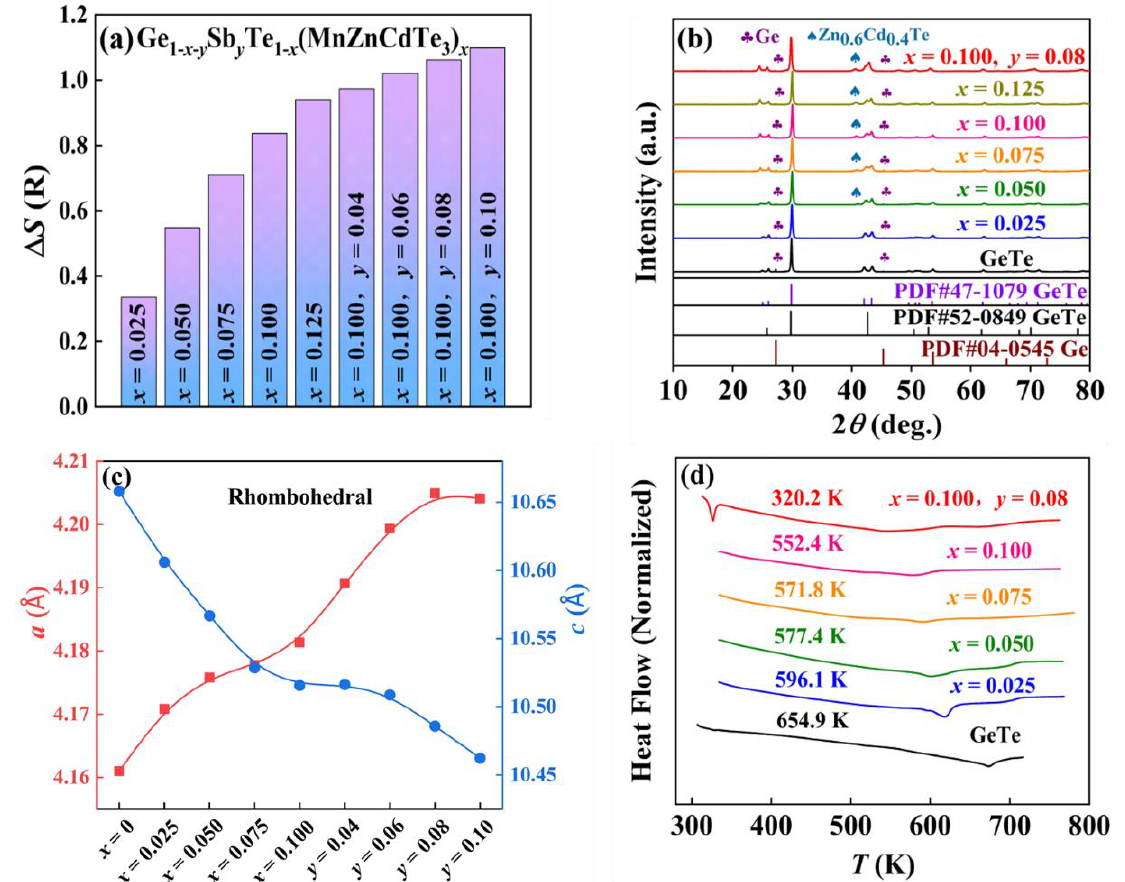
Figure 1. Room temperature ( a ) configurational entropy Δ S , ( b ) powder XRD patterns, ( c ) lattice parameter a and c , and ( d ) DSC curves and the obtained phase transition temperature T c of GeTe- based alloys.